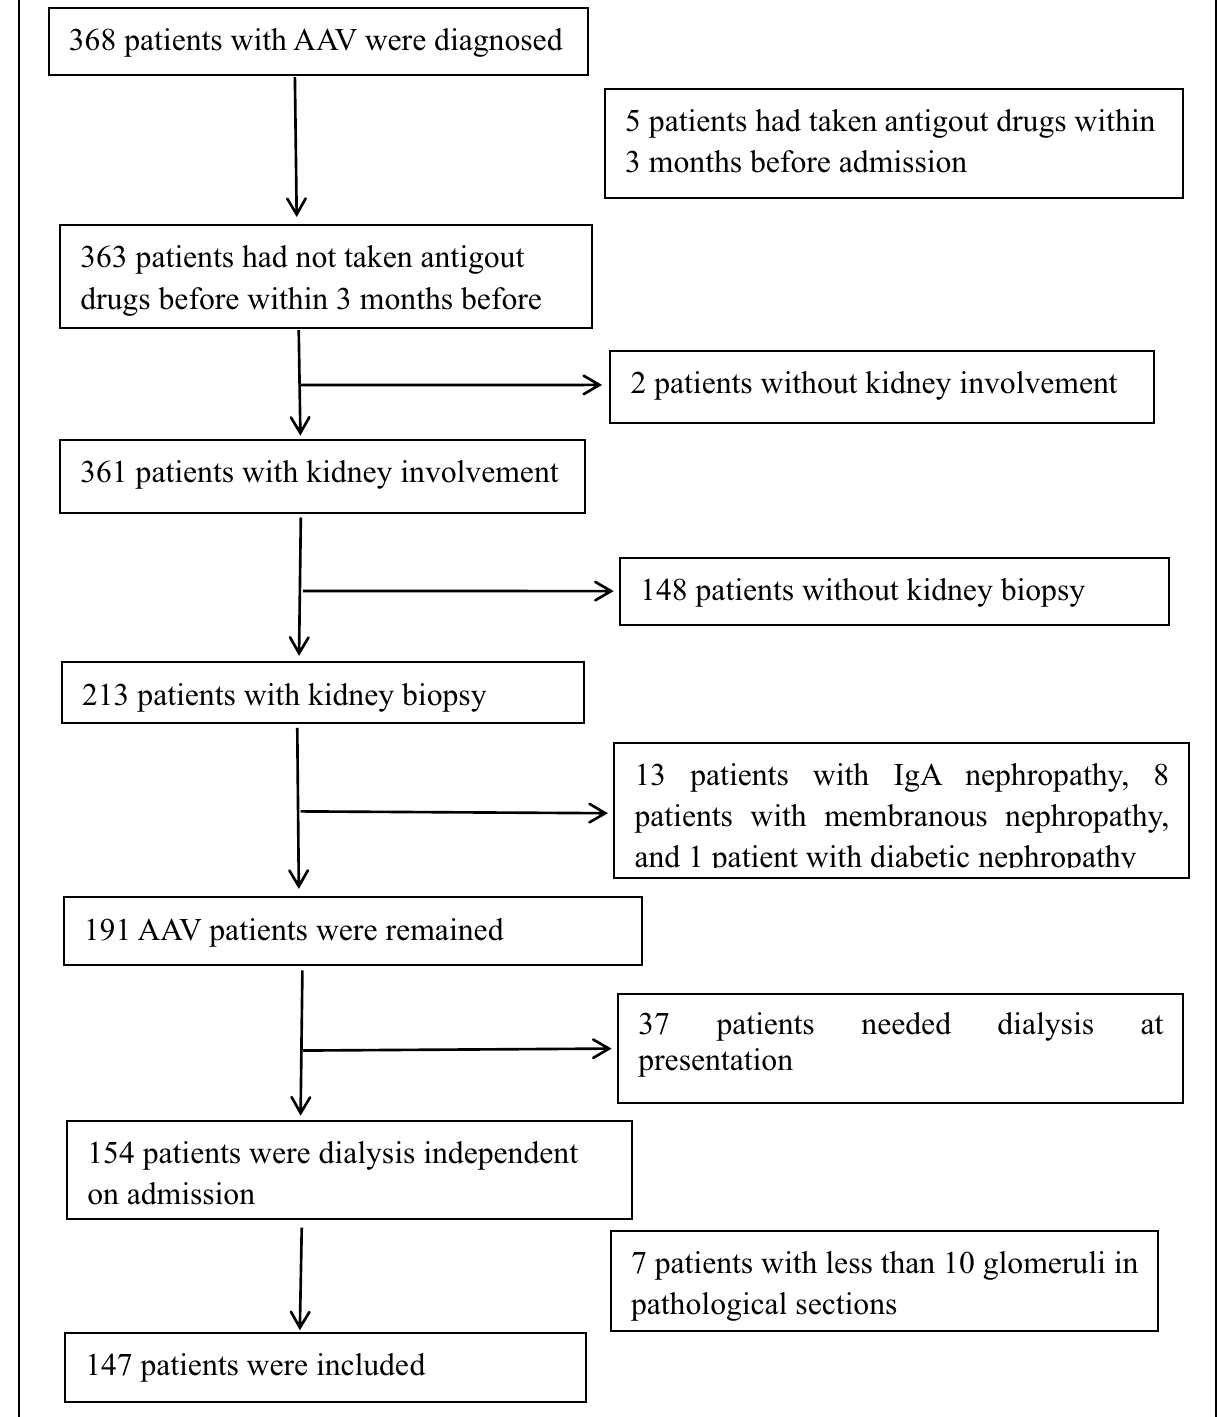
Figure 4. Patients selection flowchart. A total of 368 patients with AAV were diagnosed. 5 patients had taken antigout drugs within 3 months before admission and 2 patients without kidney involvement were excluded. Among remaining 361 patients, 148 patients did not receive kidney biopsy. 13 patients with IgA nephropathy, 8 patients with membranous nephropathy, and 1 patient with diabetic nephropathy were excluded, too. 7 patients whose glomeruli less than 10 glomeruli in pathological sections and 37 patients needed dialysis at presentation were also excluded. At last, 147 patients were included in this